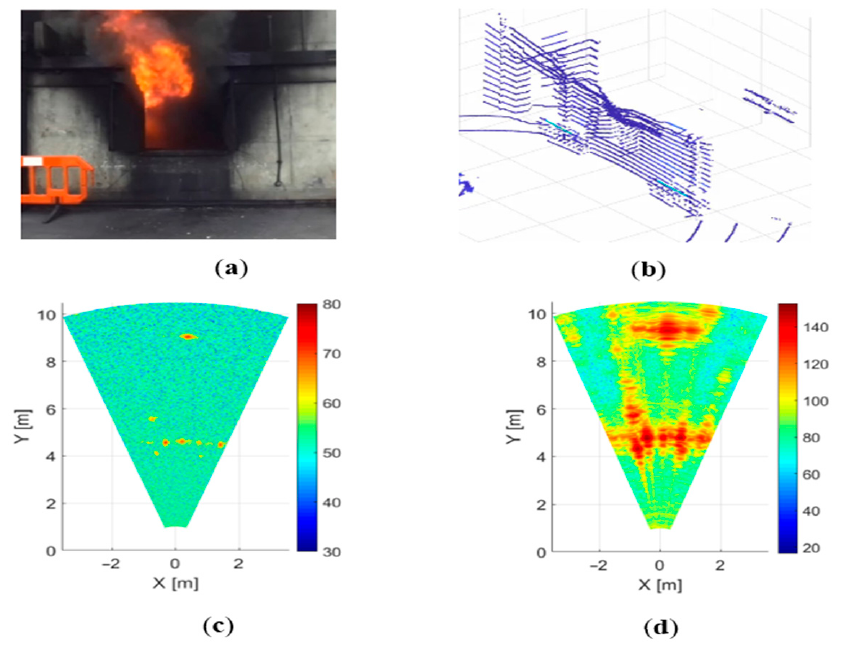
Figure 4. Dense flame environment: ( a ) camera, ( b ) LIDAR, ( c ) 300 GHz radar and ( d ) 79 GHz ra- dar.